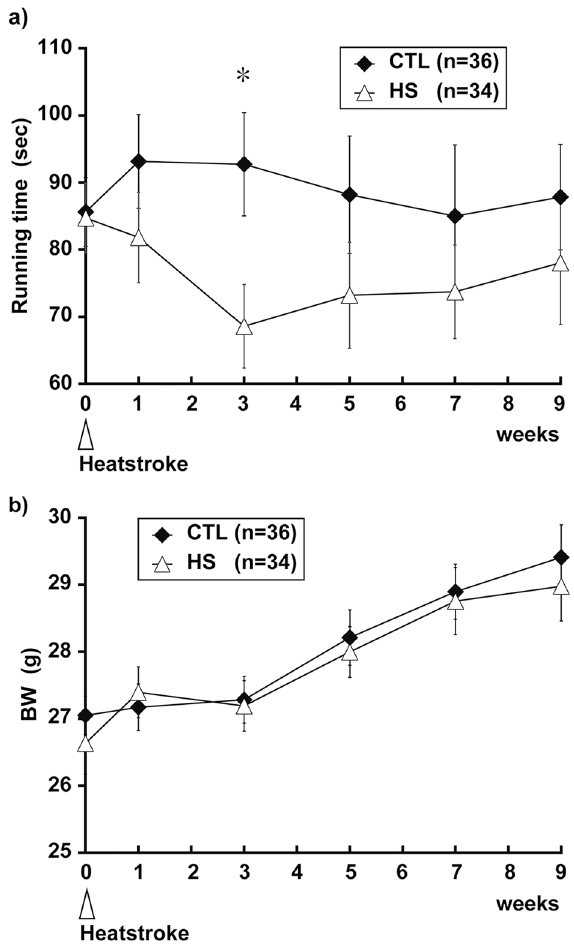
Figure 1. Motor coordination and body weight for 9 weeks after heatstroke. Running time of the rotarod test ( a ) and body weight ( b , BW) in the control (CTL) and heatstroke (HS) animals. The running time of the rotarod test in the HS animals 3 weeks after heatstroke significantly decreased compared with that in CTL animals. BW in the HS and CTL groups did not change significantly over the experiments. Data are expressed as mean ± standard deviation (SD) (* P < 0.05, Tukey–Kramer test). HS heatstroke, CTL control, BW body